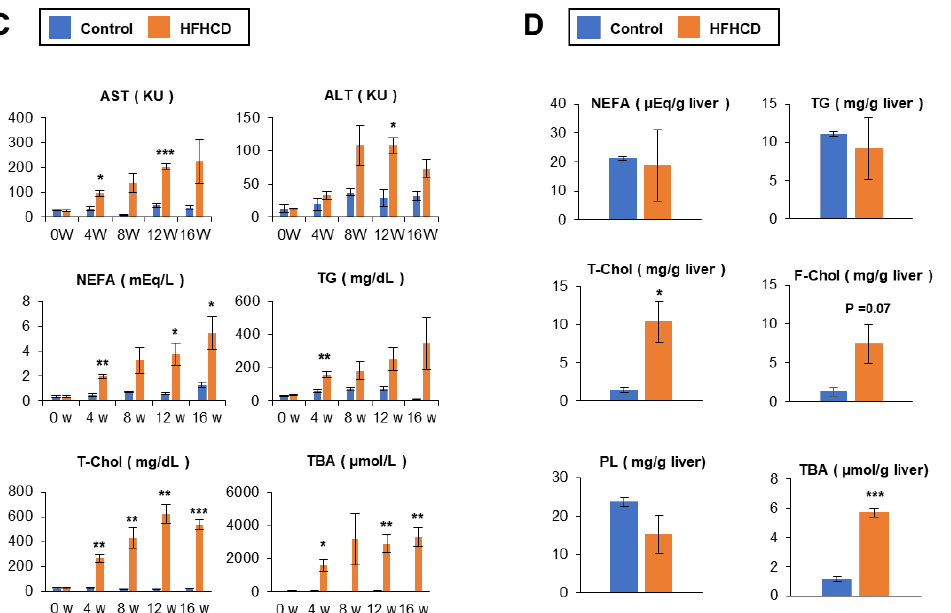
Figure 1. HFHCD induced advanced liver fibrosis and hyperlipidemia in rabbits. ( A ) Liver tissue of the control and 16-week HFHCD groups. ( B ) Histochemical staining of the liver and aorta of the control and 16-week HFHCD group; HE staining of the liver (upper); scale bar = 100 µ m, Azan– Mallory staining (middle); scale bar = 100 µ m, HE staining of the aorta (bottom); scale bar = 400 µ m. ( C ) Serum biochemical profiles of the control and HFHCD-fed rabbits. ( D ) Hepatic lipid and bile acid profiles of the control and 16-week HFHCD groups. Data are shown as the mean ± SEM. * p < 0.05, ** p < 0.01, and *** p < 0.001 vs. control group. Control group (n = 3), HFHCD group (n = 3).